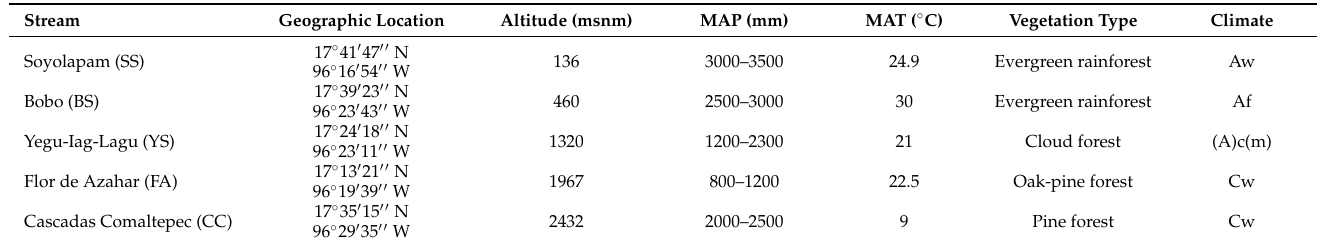
Table 1. Study sites in the Sierra de Ju á rez, Oaxaca, Mexico. MAP = mean annual precipitation; MAT = mean annual temperature. Climate according to Garc í a notation